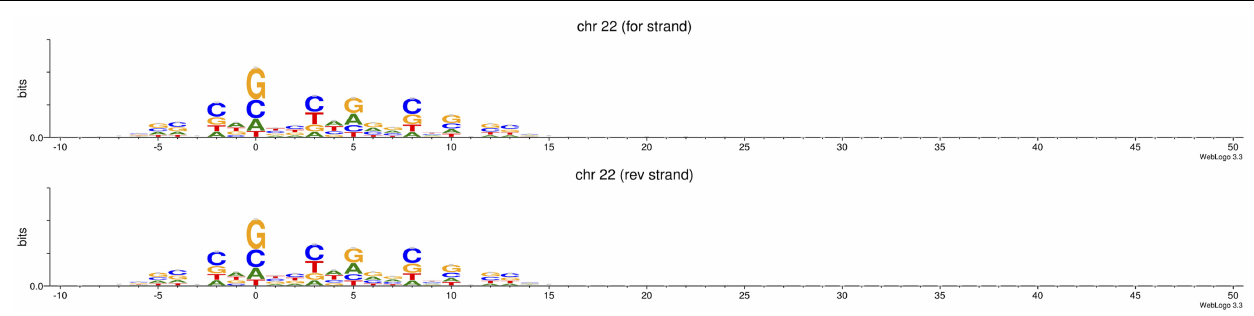
FIGURE 1 | Tn5 transposase shows sequence cleavage bias . Data represented correspond to read-start sites in reads aligned to forward and reverse strands in chromosome 22 in four ATAC-seq replicates (50k cells per replicate) reported in Buenrostro et al. (2013). Of total, 50bp PE reads were pre-processed with Trimmomatic v0.32 under default parameters, and then aligned to hg19 using BWA v0.7.4-r385 (Li and Durbin, 2010; Bolger et al., 2014). Sequence logos were generated using WebLogo (Crooks et al., 2004). Y -axis: 0.0–0.3 bits.